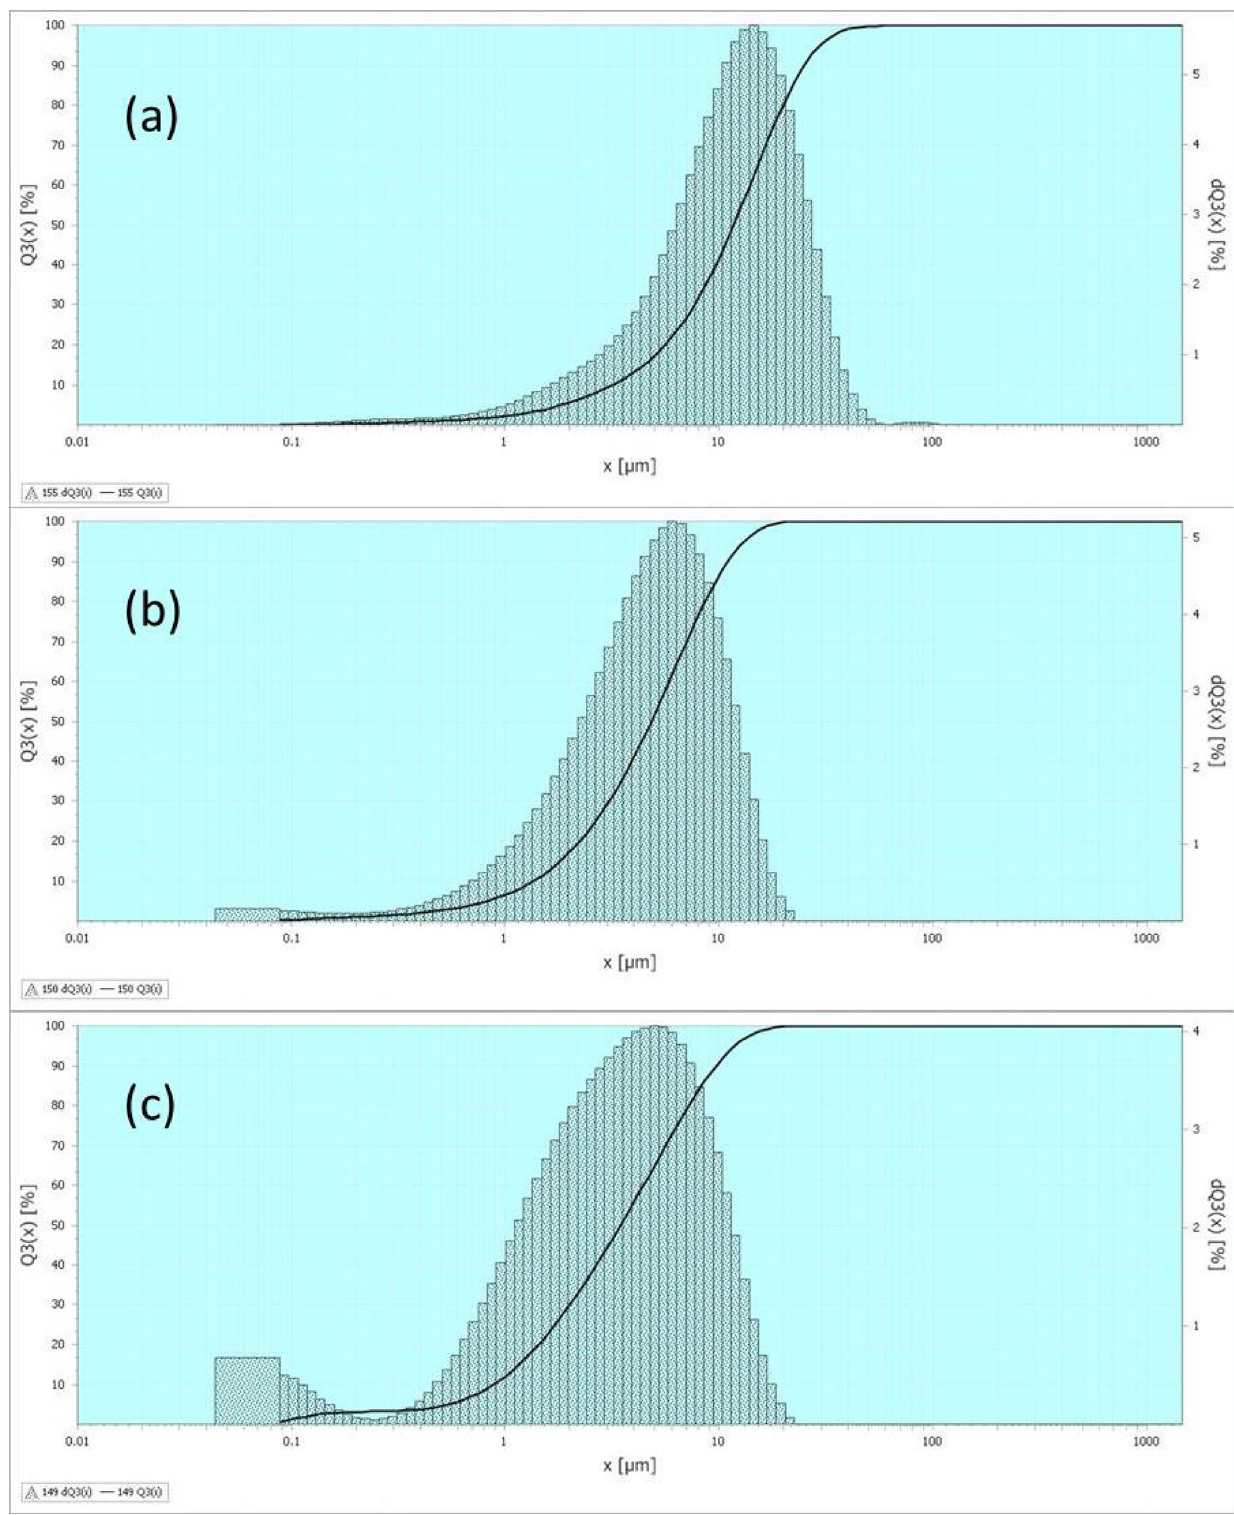
Figure 3. Results of the mean particle size analysis by the laser particle analyser for ( a ): MMT, ( b ): kaolinite, ( c ): SHNT (device measuring range: 100–20,000